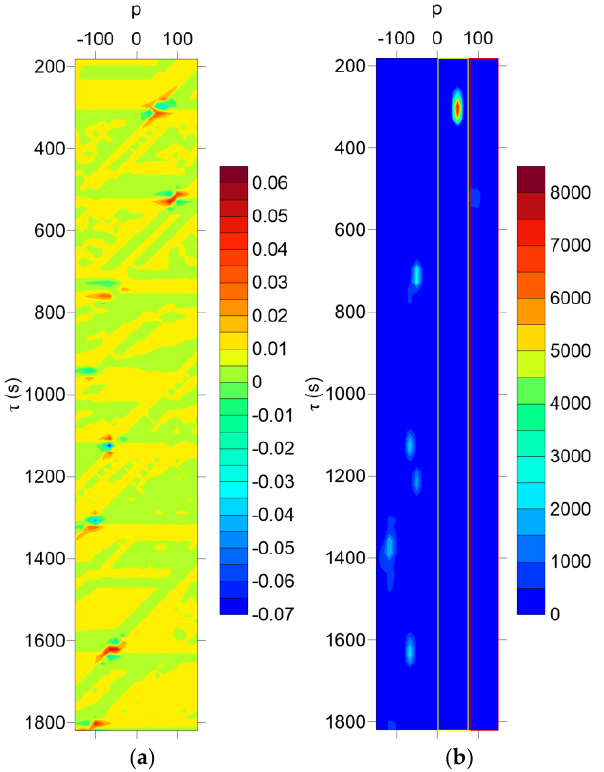
Figure 6. The results for the ( a ) traditional and ( b ) modified linear Radon transform based on the synthetic VSP records.